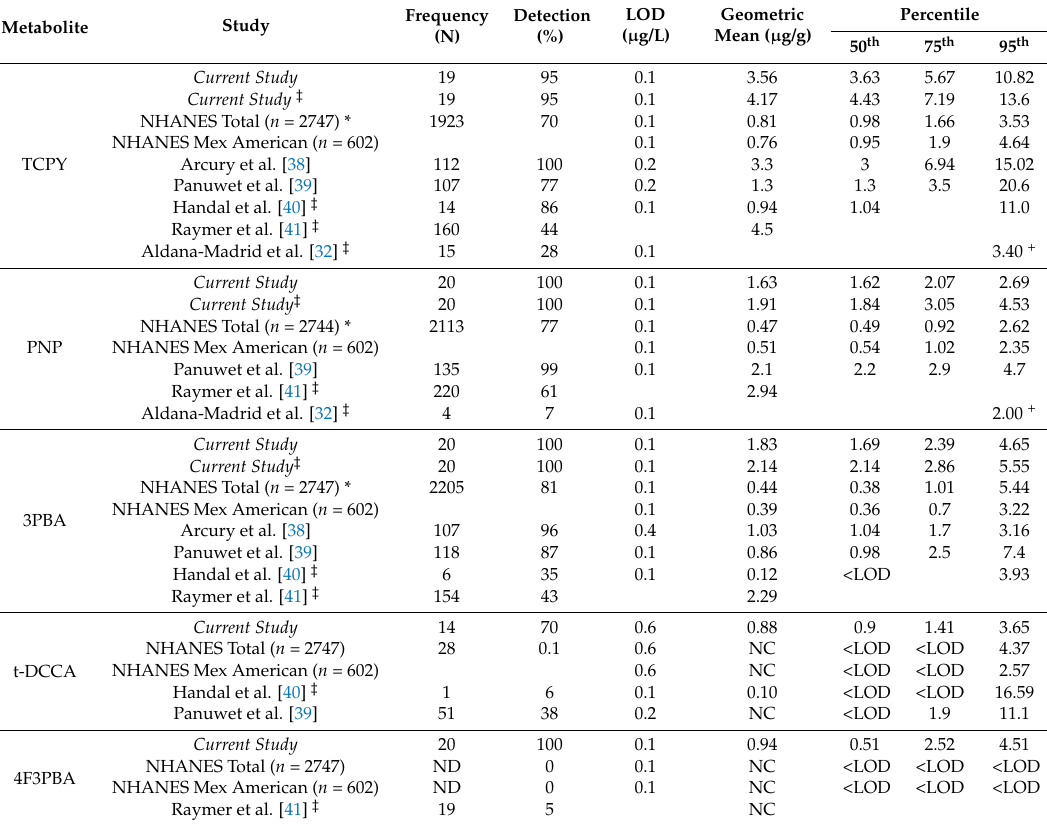
Table 5. The comparison of study results for urine metabolites with results from other